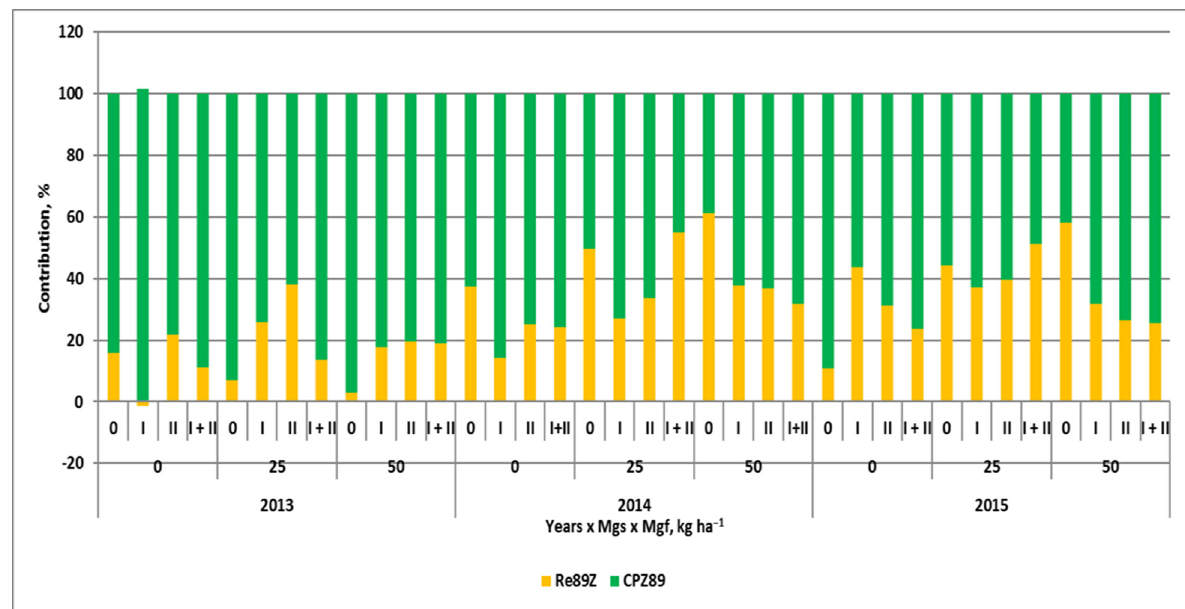
Figure 12. Effect of magnesium fertilization systems, on the background of years, on contribution of the remobilized dry matter and the current photosynthesis in the grain yield at BBCH 89. Legend: Mgs, Mgf—soil and foliar Mg fertilization systems, respectively; I—BBCH 30; II—BBCH 49/50.